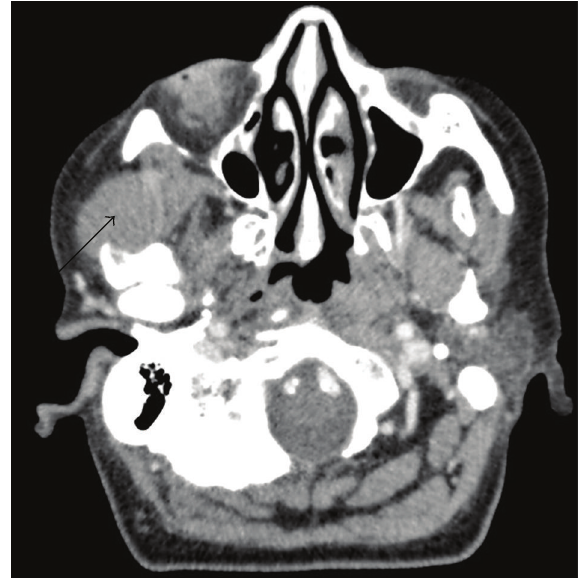
Figure 3: CT axial section showing tumour invading right zygo- matic